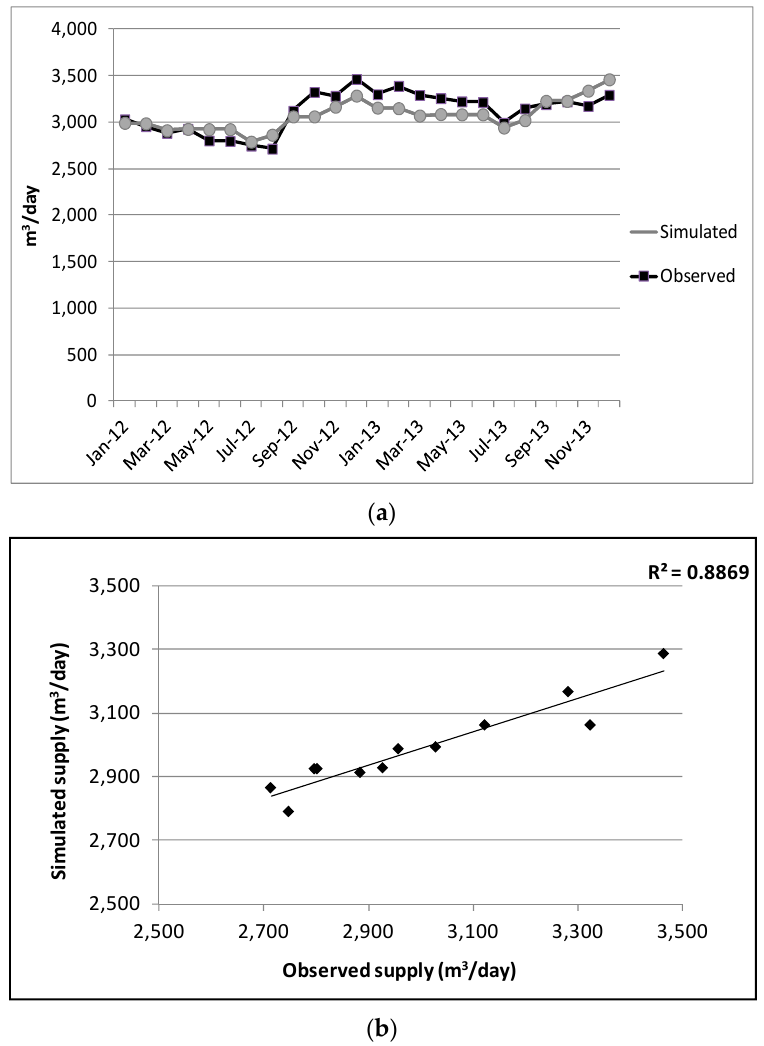
Figure 4. Comparison between simulated and recorded supply as ( a ) a time series of supply and ( b ) scatter plot. Table 4. Selected monthly coefficients for Puerto Ayora.